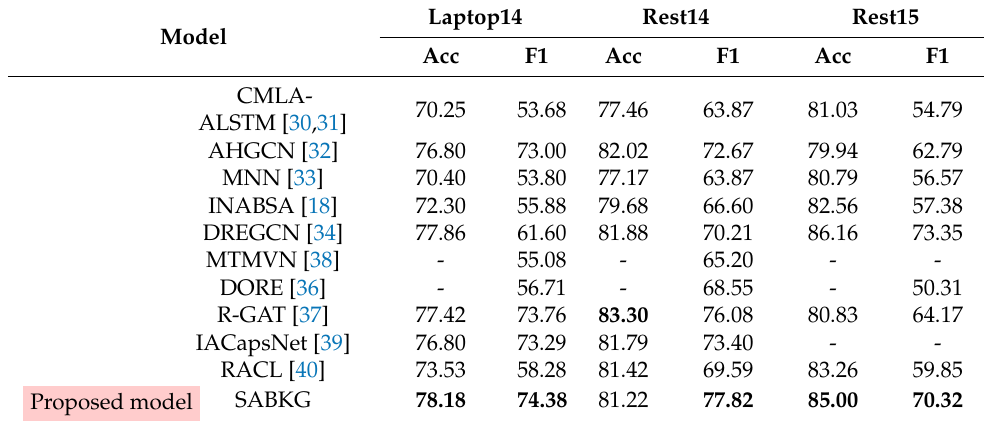
Table 2. comparison of different models’ performance.